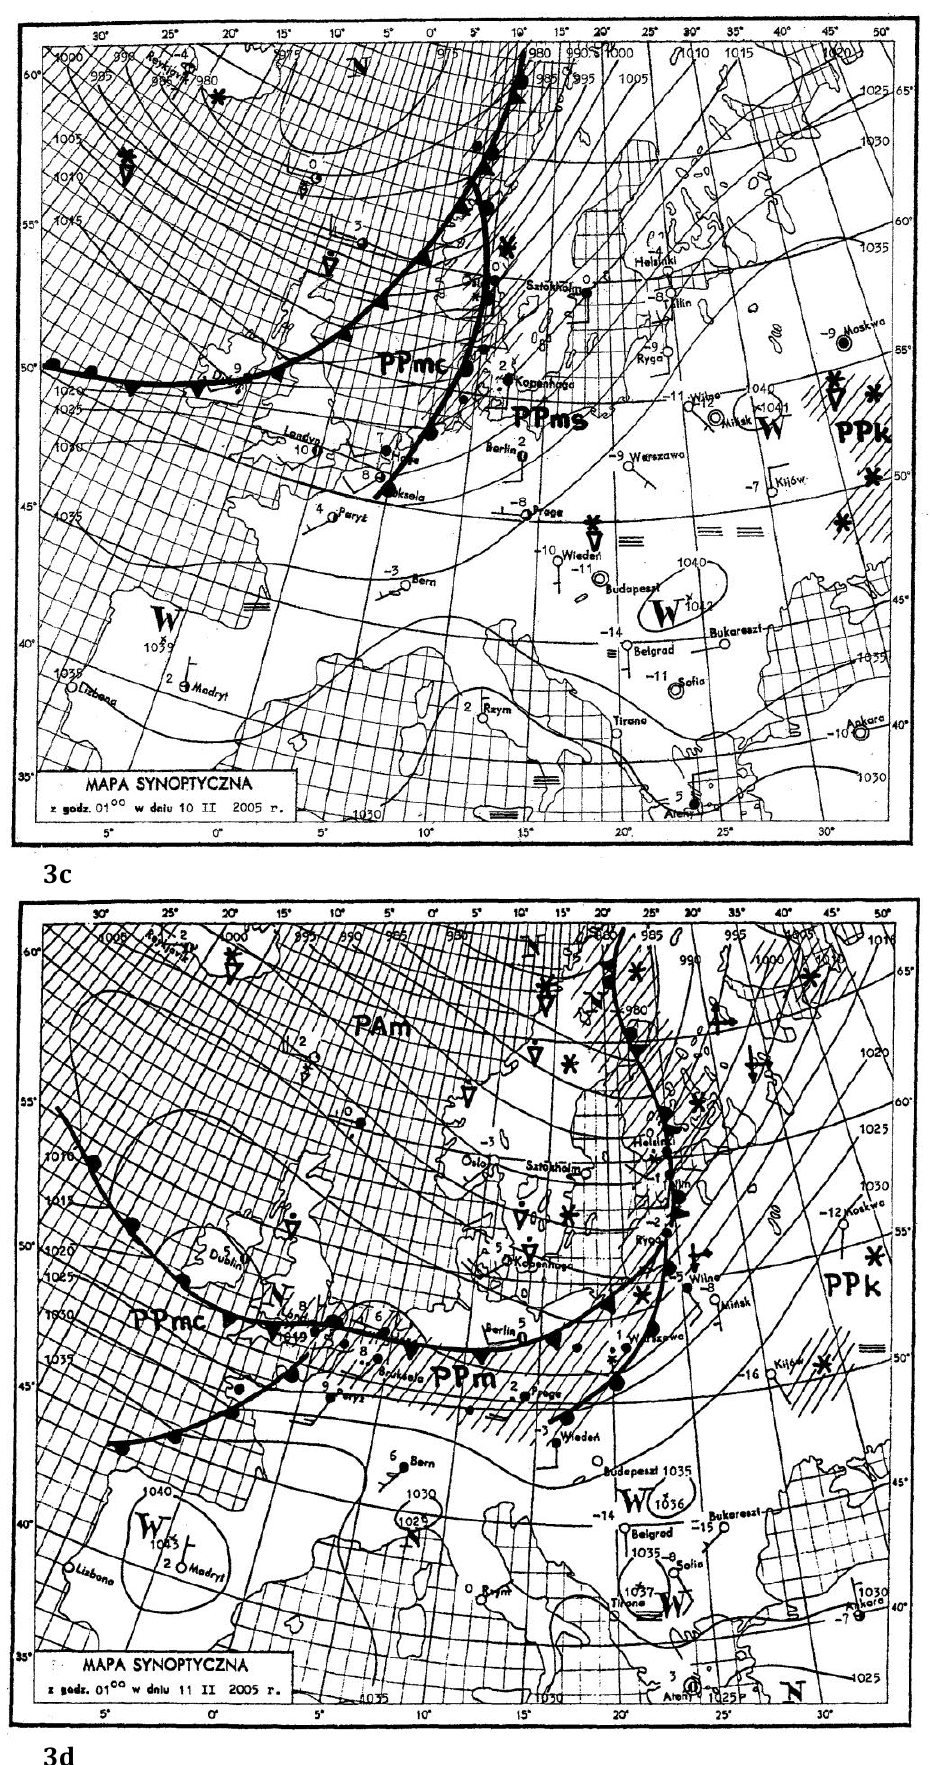
Fig. 3. Synoptic situation during 04-11 February